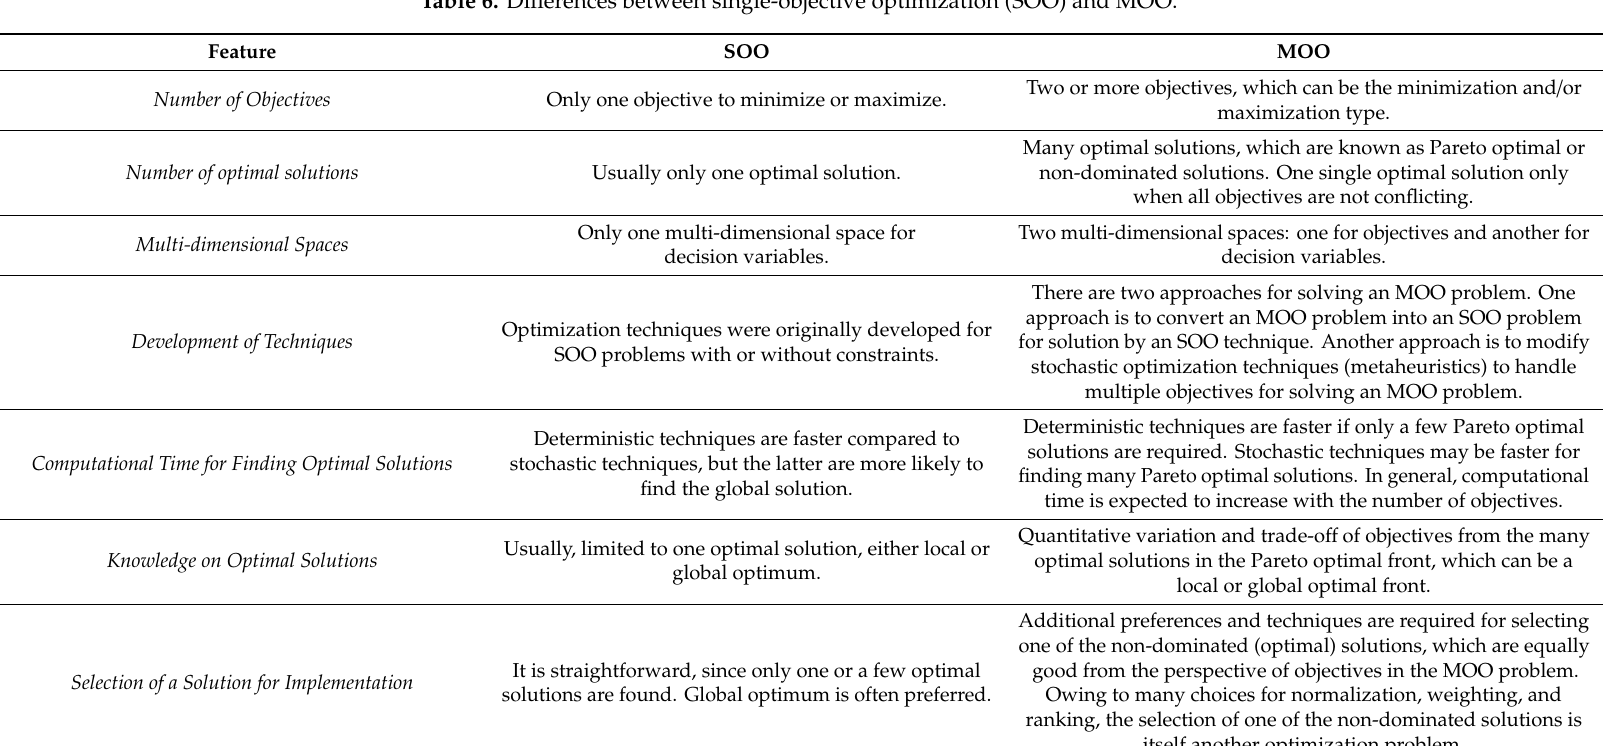
Table 6. Di ff erences between single-objective optimization (SOO) and